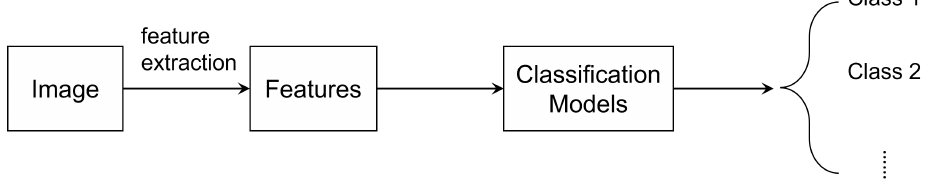
Figure 7. Simplified flowchart for image